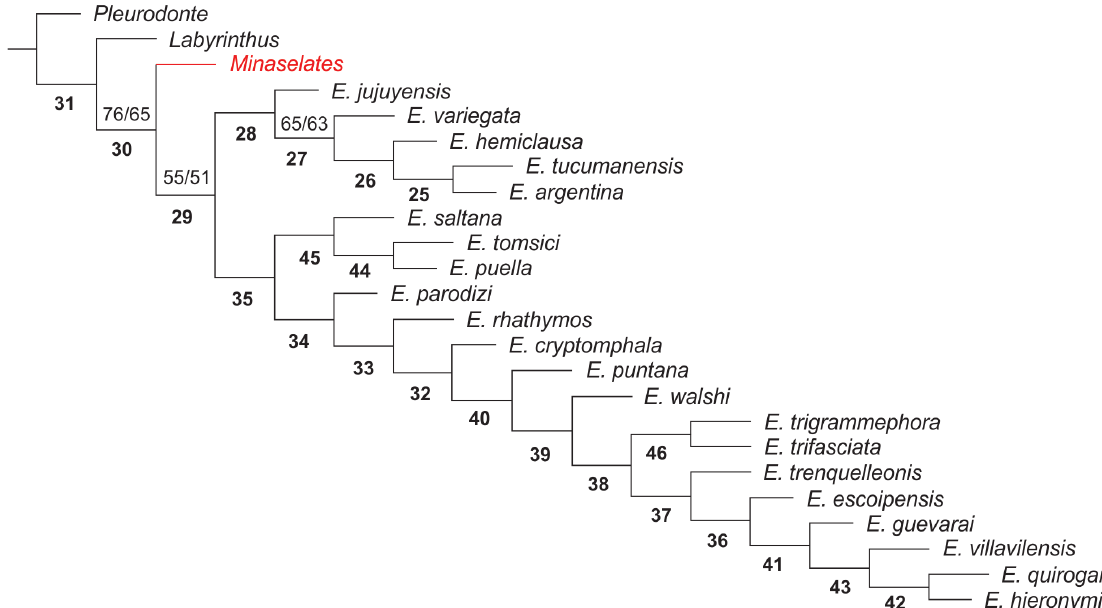
Figure 27. Consensus tree obtained from two trees under implied weight approach highlighting the position of Minaselates gen. n. Only taxa with described anatomy were included in the matrix. Numbers below branches are node numbers. Symmetric resampling values (left number) and jackknife values (right number) are located above branches. Only values above 50% are illustrated. ZOOLOGIA 34: e13230 | DOI: 10.3897/zoologia.34.e13230 | April 27,